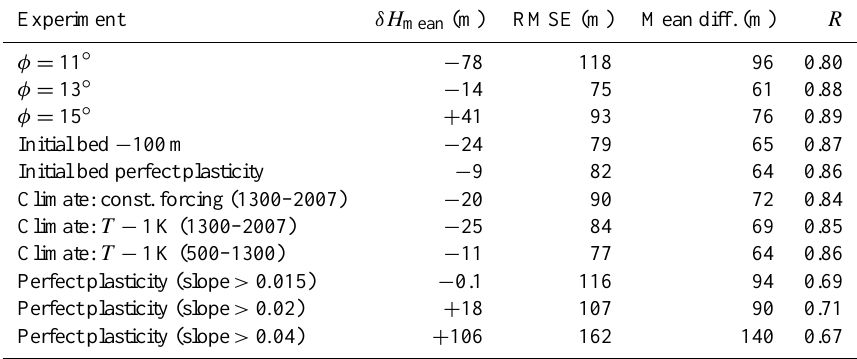
Table 1. Comparison of modeled and theoretically derived ice thicknesses with observations along the radar track (Fig. 6b). δH mean is the discrepancy between modeled and observed mean thickness (2nd column). The 3rd, 4th and 5th column present the root-mean-square error (RMSE), the mean absolute difference and the correlation coefficient ( R ), respectively. The mean observed ice thickness is 322m. Experiment δH mean (m) RMSE (m) Mean diff. (m) R φ = 11 ◦ − 78 118 0.80 φ = 13 ◦ −